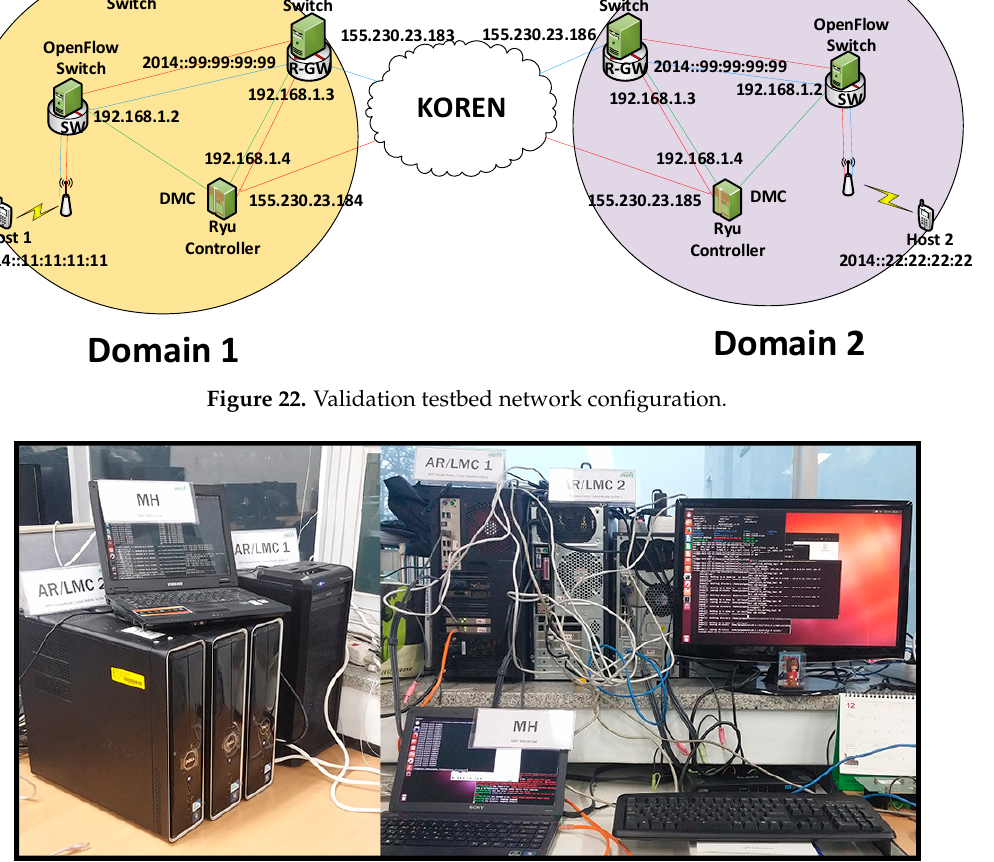
Figure 23. Testbed snapshot for